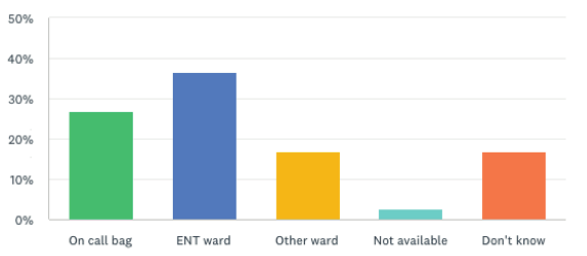
Figure 7. ‘What is the availability of urinary catheters and umbilical clips?’